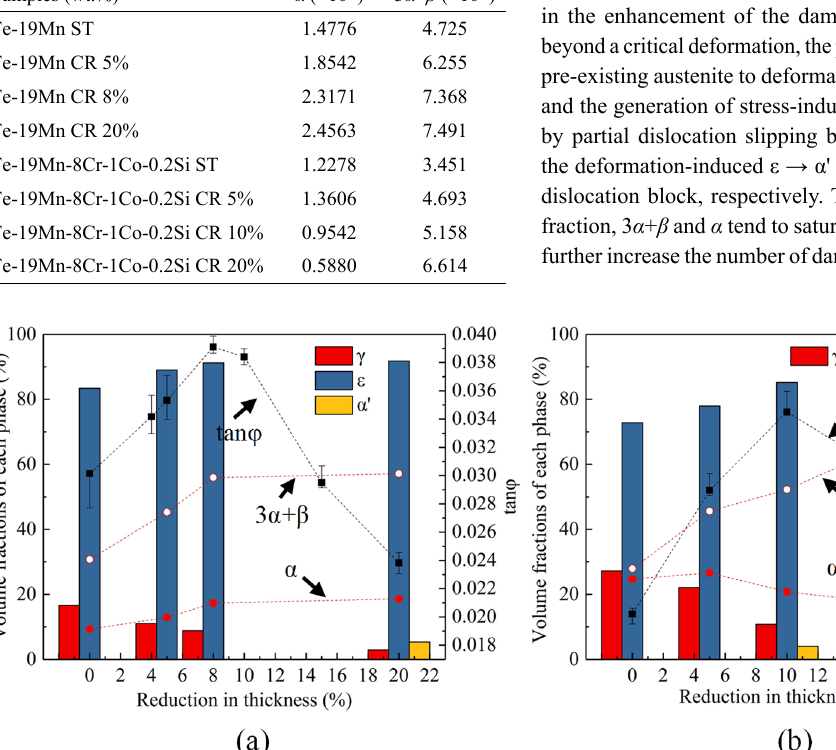
Table 3. Stacking fault probabilities of γ-austenite ( α ) and ε-martensite (3 α + β ) in the two alloys after solution treatment or cold rolling. Samples (wt.%)